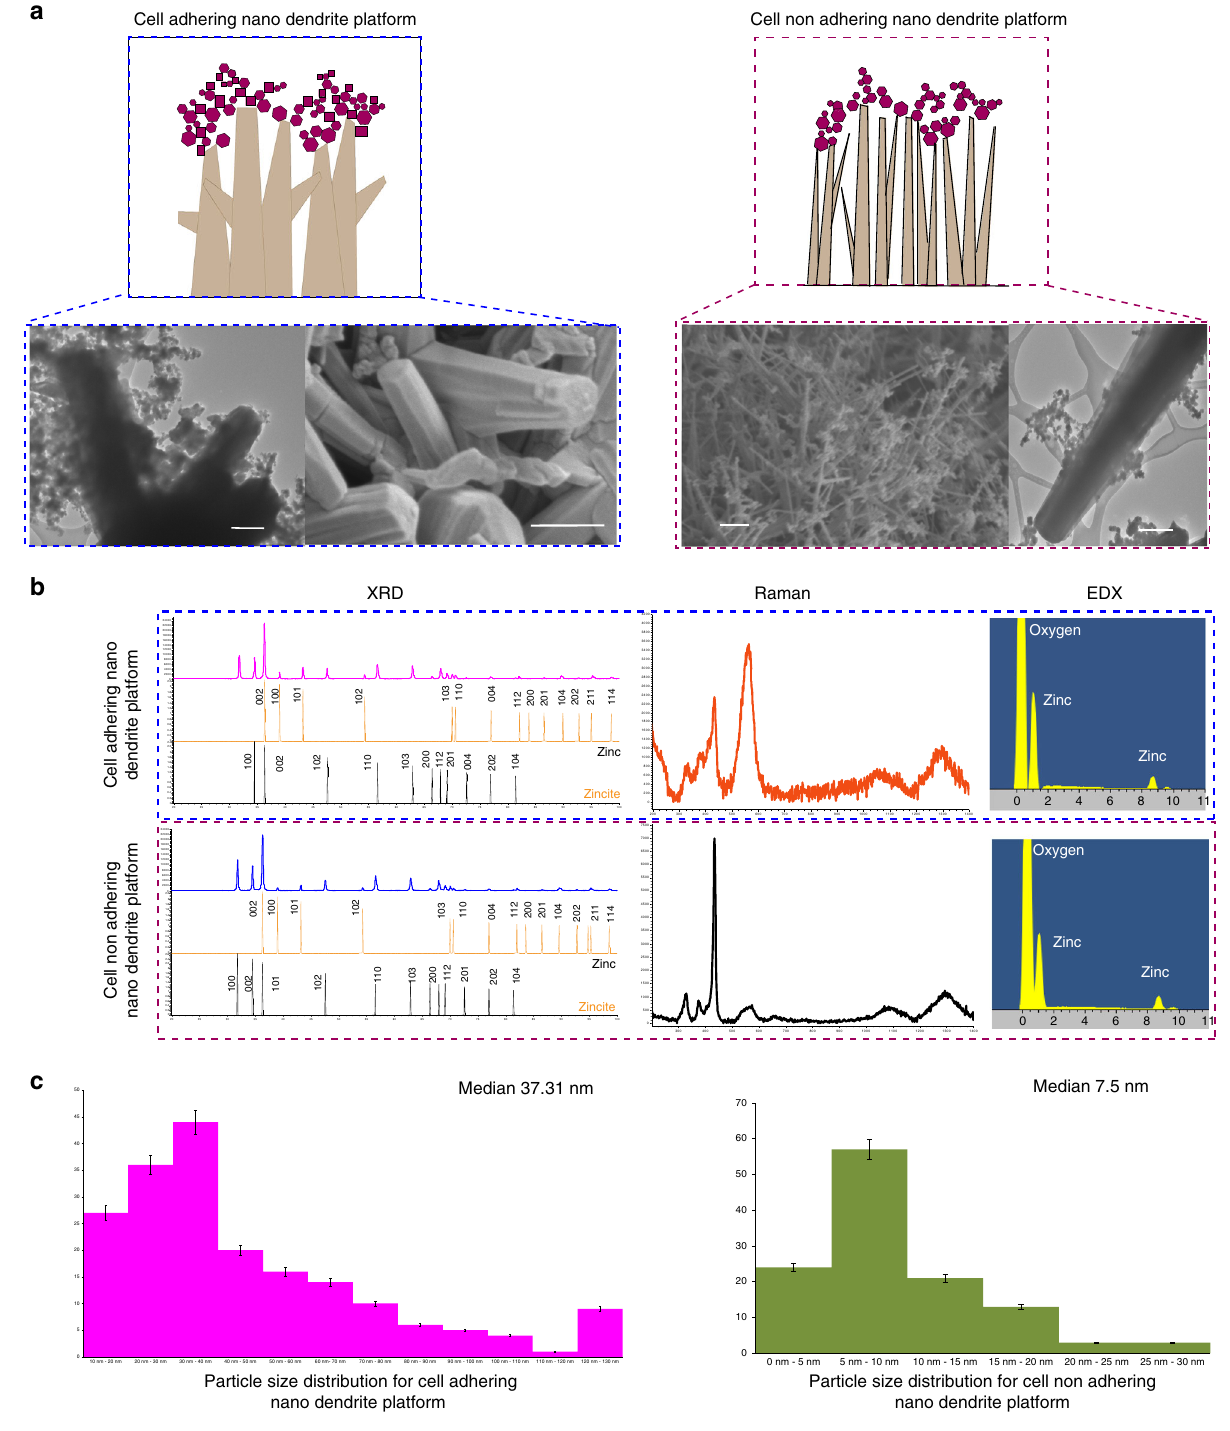
Particle size distribution for cell non adhering nano dendrite Fig. 2 Characterization of three-dimensional nano-dendrite platform. a FESEM and TEM reveals cell-adhering interface with blunt, tetrapod morphology, whereas non-cell-adhering nanorods have sharp and needle-like structures. Scale bar = 500 nm. b Elemental analysis with XRD, Raman, and EDX con fi rms formation of ZnO material. “ x ” axis displays 2-theta (deg) and “ y ” axis displays intensity (arb. units). c “ x ” axis displays the size bins and “ y ” axis displays frequency. Particle size distribution charts include error bars in S.D. Total n = 313 samples were measured. Nano-dendrite platform was classi fi ed as cell adhering and cell non-adhering charge transfer mechanism due to Herzberg – Teller coupling 19 . and plasmon resonances 47 . The exciton resonance results in SERS Pulsed laser deposition produces very high carrier mobilities. due to charge transfer by Herzberg – Teller coupling either from According to the Hamiltonian of semiconductors, very high molecular highest occupied molecular orbital to the conduction mobility of charge carriers because of the 3D arrangements of band edge or from valance band edge to molecular lowest ZnO quantum crystals may result in the combination of exciton unoccupied molecular orbital. This charge transfer resonance